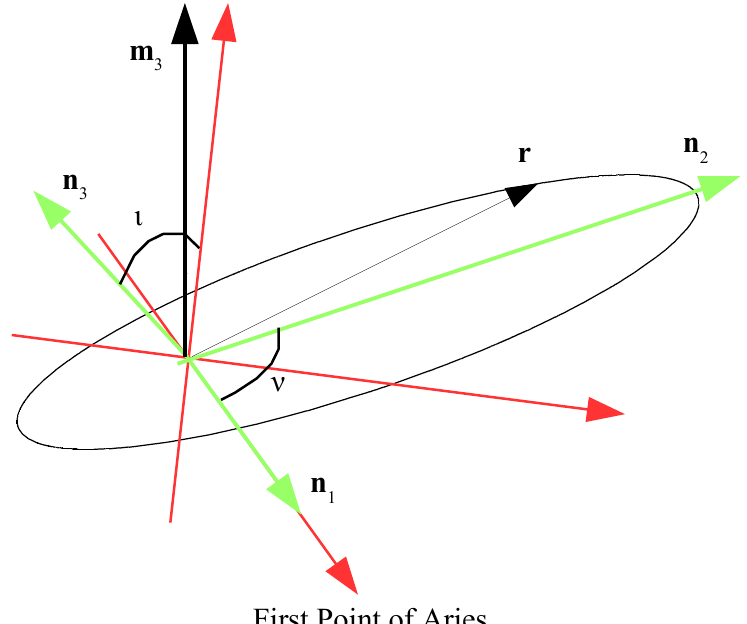
Figure 1. The relative orientation of the reference systems used in the calculations is as follows: the orthogonal system of reference corresponding to the ecliptic plane is shown in red; the system of a typical planetary orbit ( ˆ n , i = 1 , 2 , 3 ) in green; and the rotational axis i of the Sun is ˆ m . The true anomaly, ν , is the angle between the planet’s radius vector and 3 the line of nodes (which in this plot coincides with the line pointing towards the first point of Aries). The inclination angle, ι , of the orbital plane is also